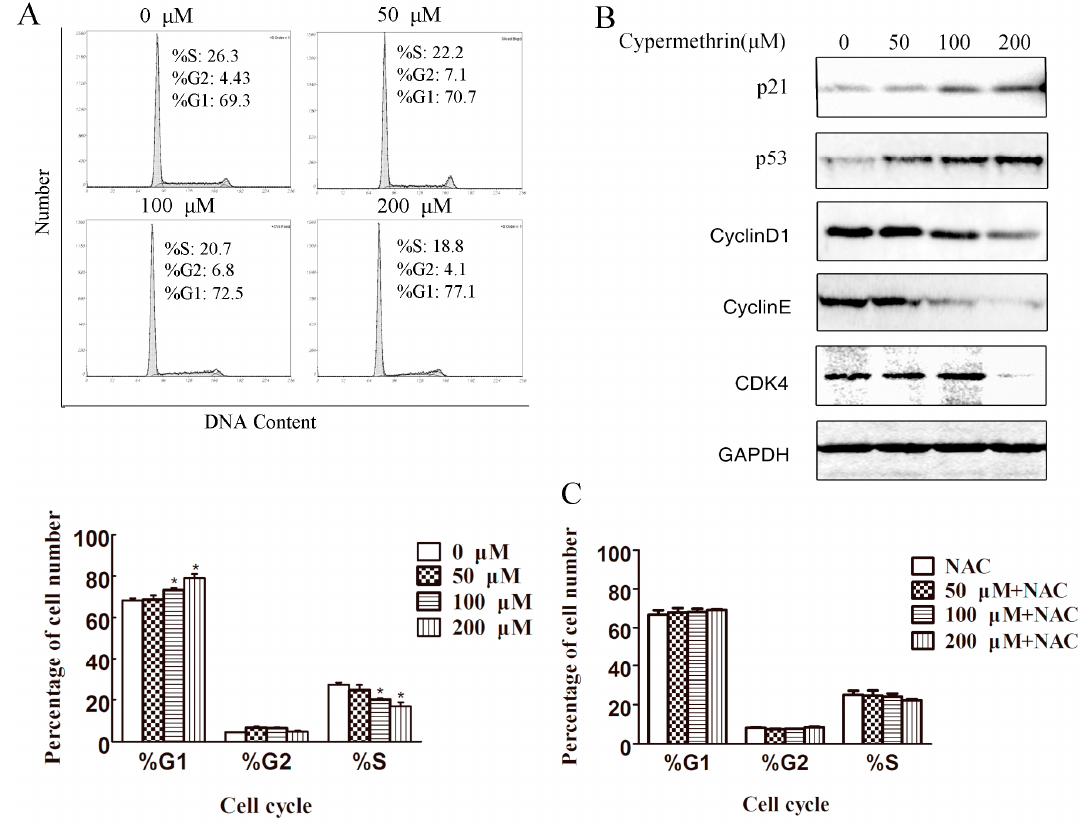
Figure 3. Cypermethrin leaded to G1 cell cycle arrest in RAW 264.7 cells. RAW 264.7 cells were treated with cypermethrin for 48 h ( A ). After treatment, cells were harvested and processed for cell cycle distribution analysis using flow cytometry; ( B ) Expression levels of p53 and G1 phase cell cycle regulators in RAW cells treated with cypermethrin. RAW cells were treated with or without cypermethrin for 48 h. After treatment, cells were harvested and cell lysates were subjected to the analysis of cell cycle regulatory proteins of G1-phase and p53 using western blot analysis; and ( C ) Cells were pretreated with 5 mM NAC for 1 h and treated with cypermethrin for 48 h. Cells were analyzed for cell cycle distribution. Quantitative data shown for G1, G2 and S phase cell population were representive of three independent experiments. * p < 0.05 as compared with vehicle alone.